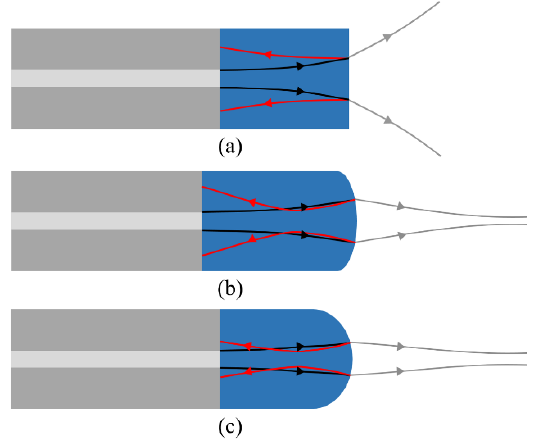
Figure 2. Various LOF structures. ( a ) LOF with a too-large radius of lens curvature ( R ). ( b ) LOF optimized as a probe for a Michelson-type interferometer. ( c ) LOF with a small R for a common-path-type interferometer. ( b , c ) are designed to have the same working distance but different back-coupling efficiency (black line: incident beam, red line: beam reflected at the LOF surface).